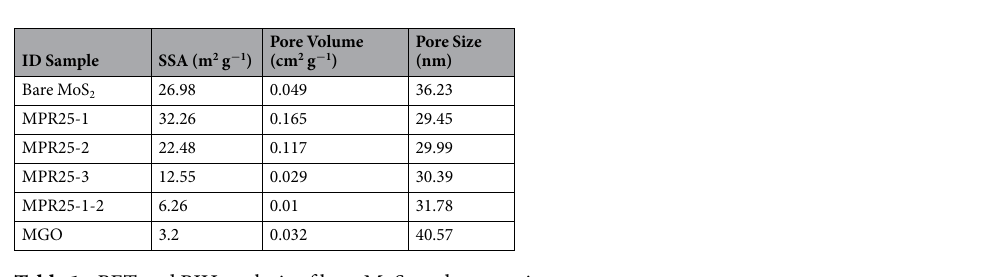
Table 1. BET and BJH analysis of bare MoS 2 and